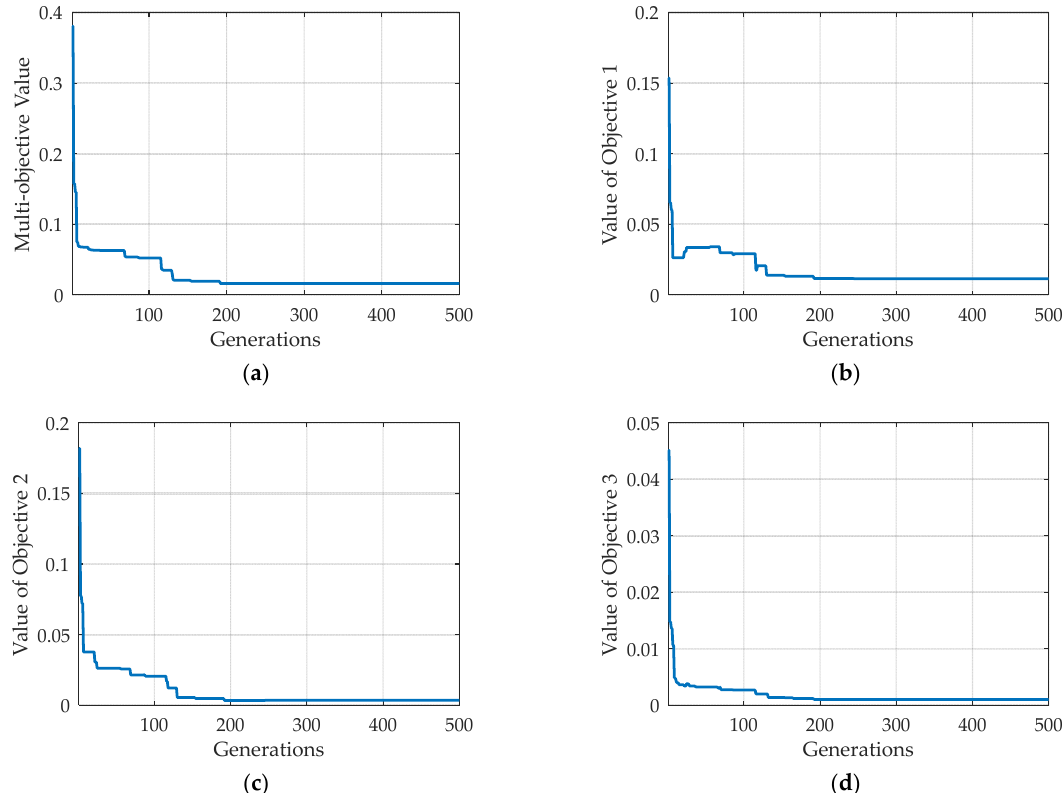
Figure 5. Convergence curve of: ( a ) multi-objective value, ( b ) value of objective 1, ( c ) value of objective 2, ( d ) value of objective 3.